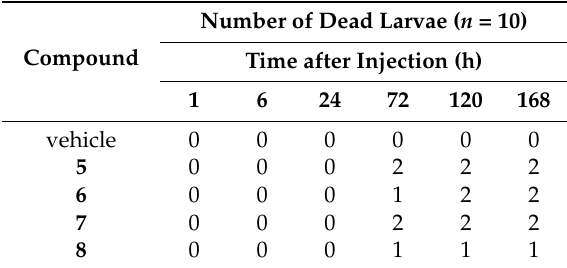
Table 2. Toxicity of 5 – 8 against silkworms by haemolymph injection a . Number of Dead Larvae ( n = 10) Compound Time after Injection (h) 1 6 24